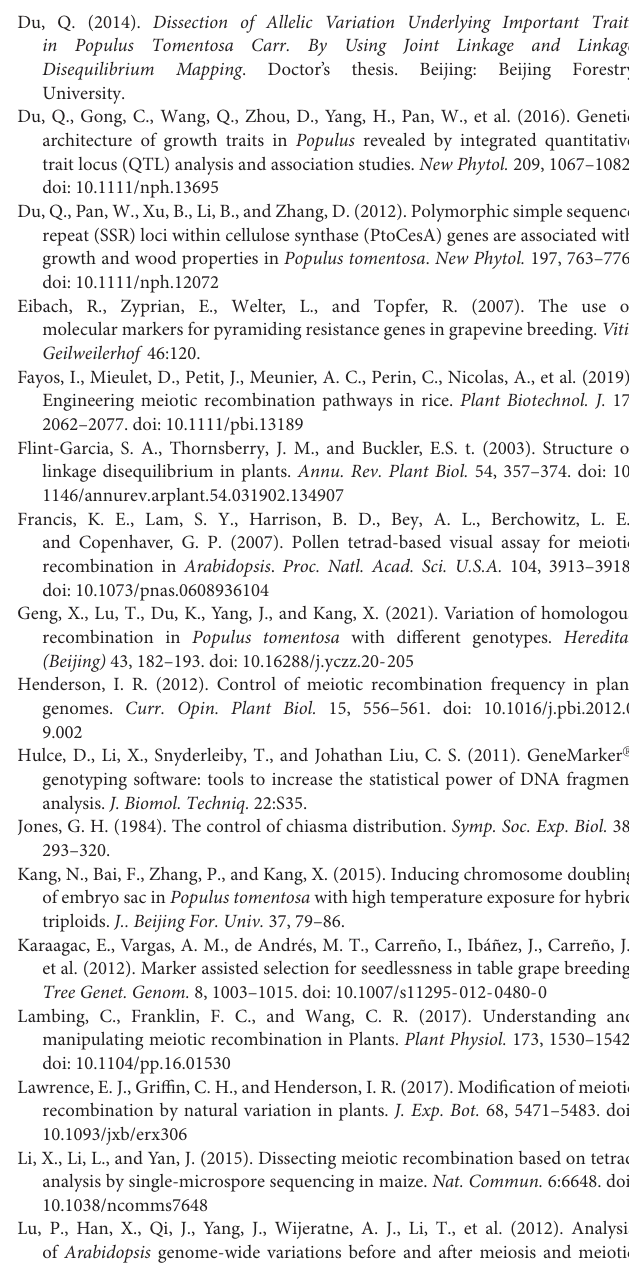
Supplementary Table 1 | Primer information to detect hDNA in P. tomentosa